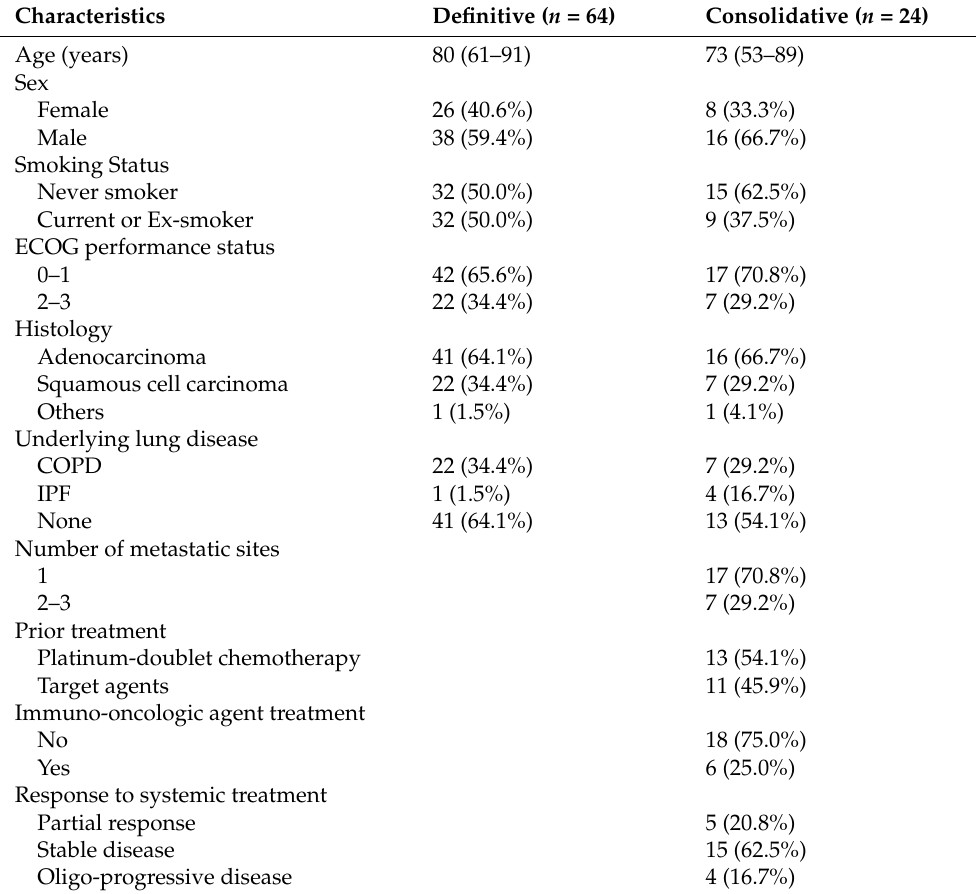
Table 1. Clinical characteristics according to treatment aim ( N =